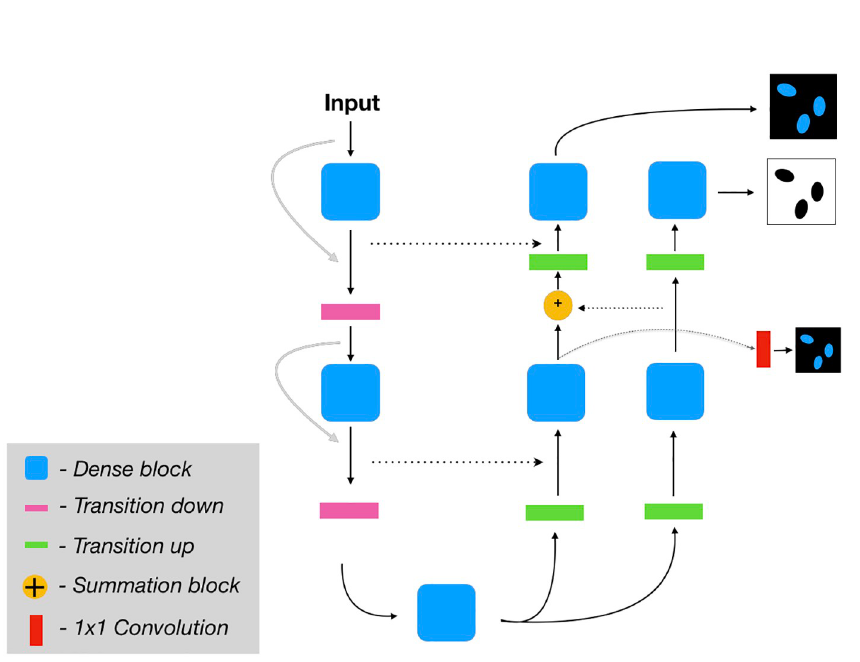
Fig 3. Proposed network for the nuclear virtual staining model which simultaneously learns the nuclear segmentation (the privileged information model, the outer-most decoder path) and the generated image for the nuclear channel (the inner-most decoder path). See Fig 4 for more information on how the information from the segmentation decoder is propagated to the image generation decoder.